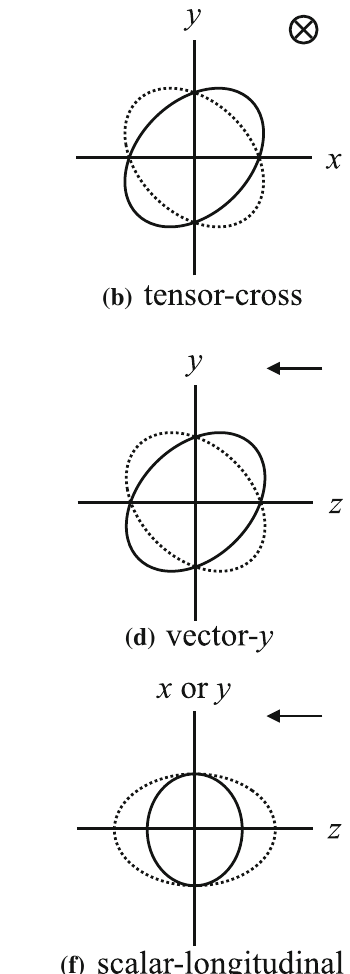
Fig. 63 Graphical representation of the six different polarization modes. The circle with a cross or arrow represents the direction of propagation of the gravitational wave. The solid and dotted circles and ellipses denote deformations to a ring of particles 180 ◦ out of phase with one another. Adapted from Fig. 1 in Nishizawa et al.